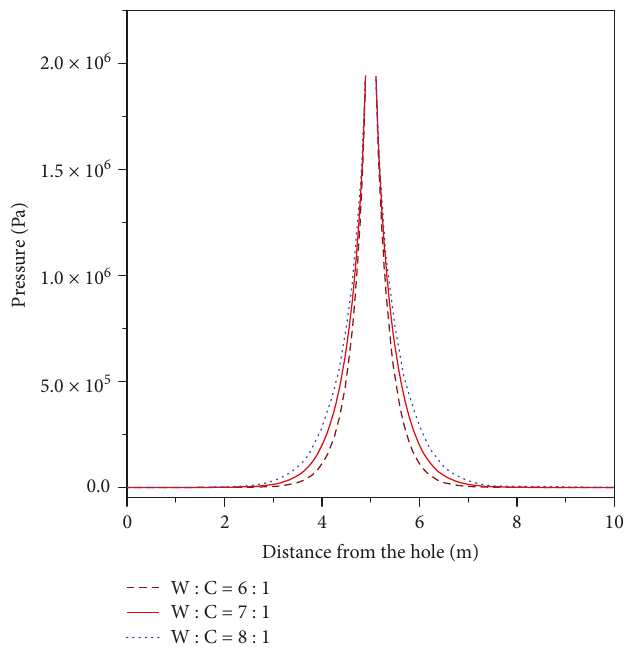
Figure 15: In fl uences of water-cement ratio on distribution of slurry pressure (time =480s, p = 2